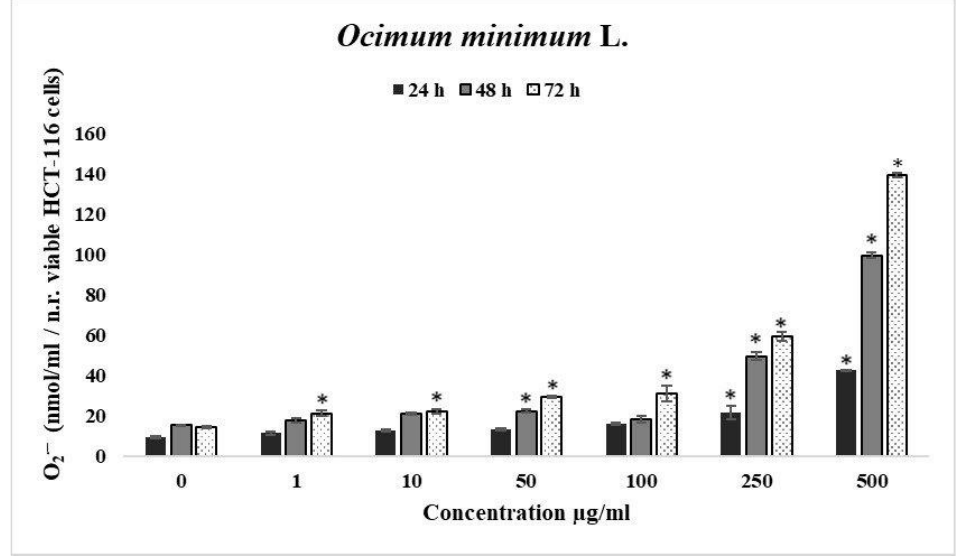
Figure 3. The concentration of superoxide anion radical (O 2∙− ) in HCT-116 colorectal carcinoma cells after 24, 48, and 72 h of O. minimum treatment. The results are presented as the mean of two independent experiments ± standard error. *Statistically significant difference (p<0.05) compared to control